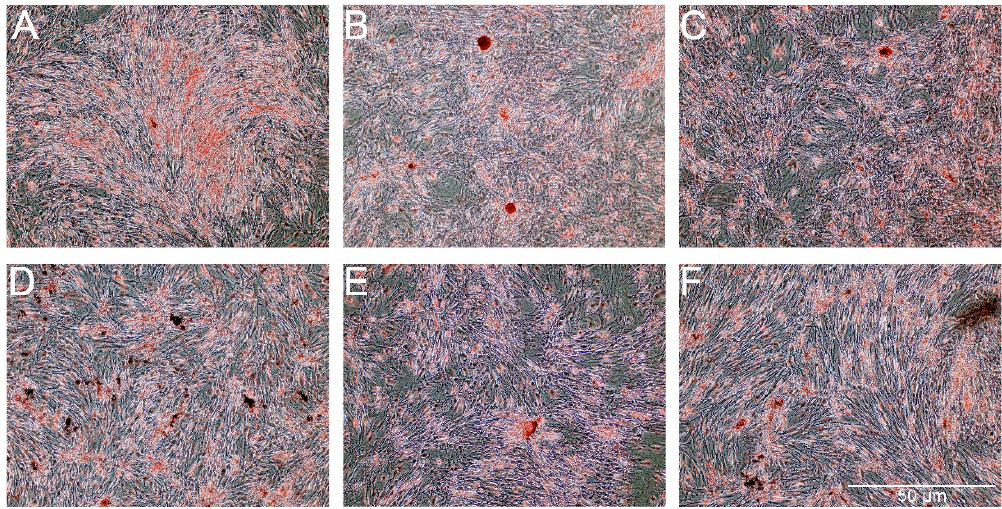
Figure 11. The Alizarin Red staining in the ADSC after exposure to the osteogenesis medium with the addition of AmB ( B ), AmB-Cu 2+ ( C ), PS ( D ), PS-AmB ( E ) and PS-AmB-Cu 2+ ( F ) compared to the control cells ( A ).